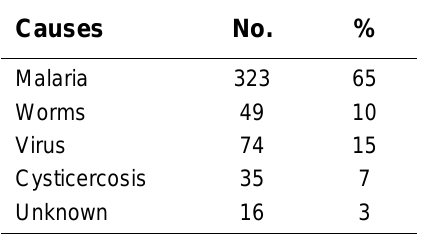
Percentage Distribution of Microbial